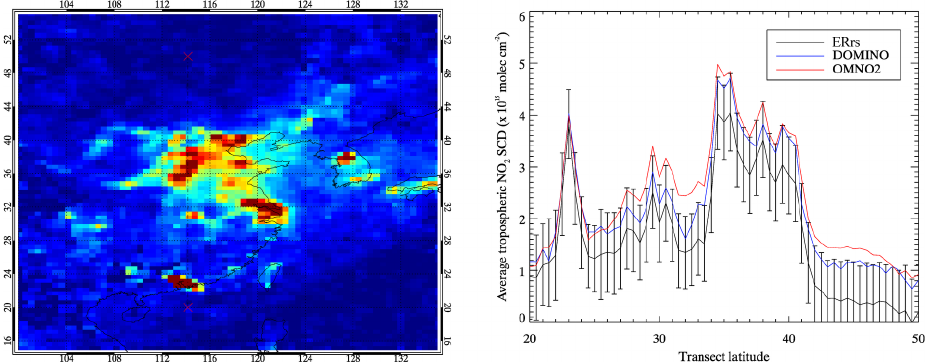
Figure 9. The mean tropospheric NO 2 SCD retrieved over the transect (20–50 ◦ N, 114 ◦ E) during June 2005. The mean tropospheric SCD retrieved by DOMINO (left, also showing the transect coordinates) was compared with that retrieved using the OMNO2 algorithm and the Earth radiance reference method (right). The error bars are the mean uncertainty of the SCDs retrieved using an Earth radiance reference, as calculated by QDOAS (Fayt et al.,